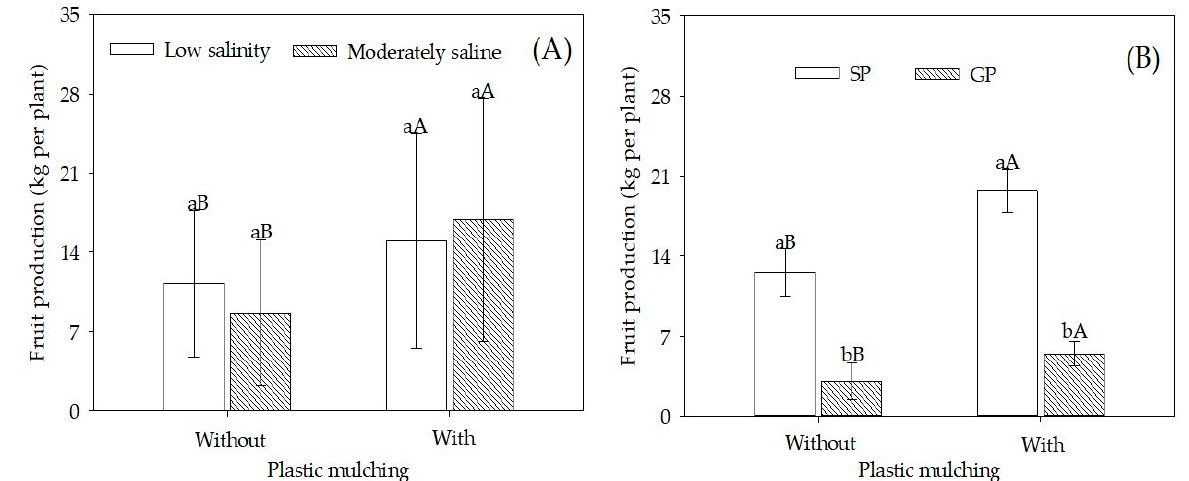
Figure 5. Fruit production of sour passion fruit seed-propagated and grafted propagated irrigated with low salinity and moderately saline waters and with and without plastic mulching. ( A ) Fruit production of sour passion fruit irrigated with low salinity and moderately saline water in soil with and without plastic mulching; ( B ) Fruit production of sour passion fruit seed-propagated (SP) and grafted propagated (GP) on Passiflora cincinnata in soil with and without plastic mulching. Vertical bars represent the standard error of the mean (n = 4). Bars with the same lower-case letter are similar for soil without and with plastic mulching ( A , B ) and bars with the same uppercase letter are similar for low salinity and moderately saline irrigation water ( A ) or seed propagation and grafting ( B ) by the F-test ( p > 0.05).